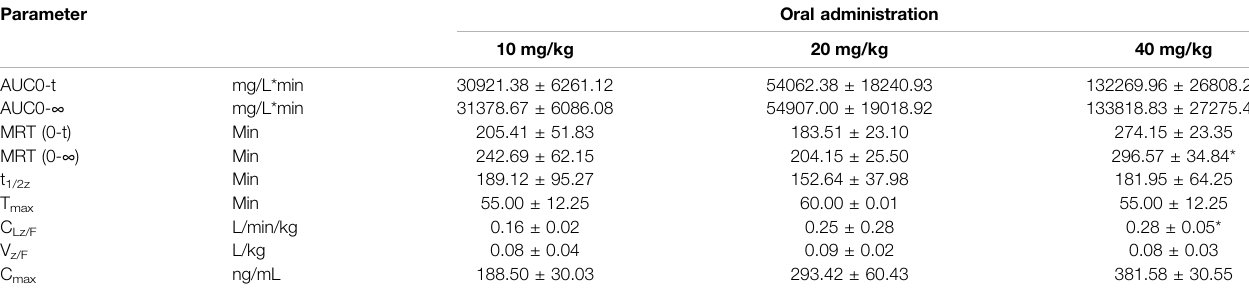
TABLE 4 | Pharmacokinetic parameters of YWS01125 after oral administration in the mice plasma (mean ± SD, n = 6). Parameter